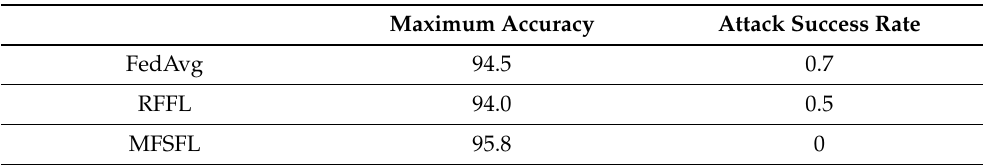
Table 5. Maximum accuracy (%) and Attack success rate (%) for MNIST under UNI with 10 G_P and additional 110%